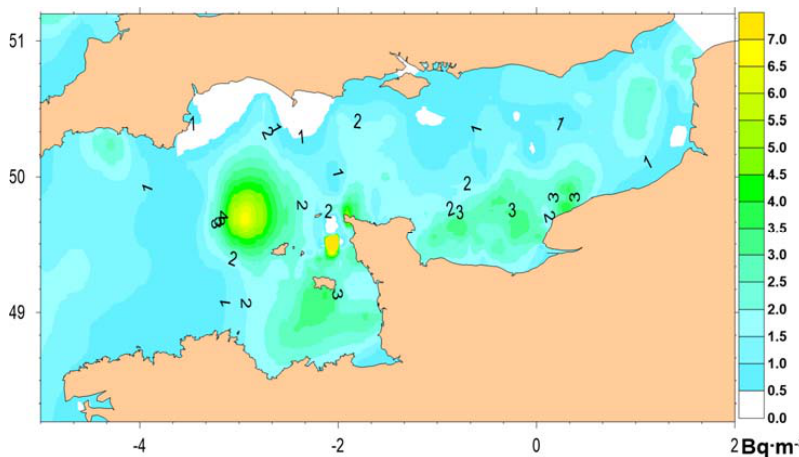
Figure 17. Calculated from Figure 16 ( 137 Cs– 134 Cs): 137 Cs not coming from La Hague (average during 1986–1994).